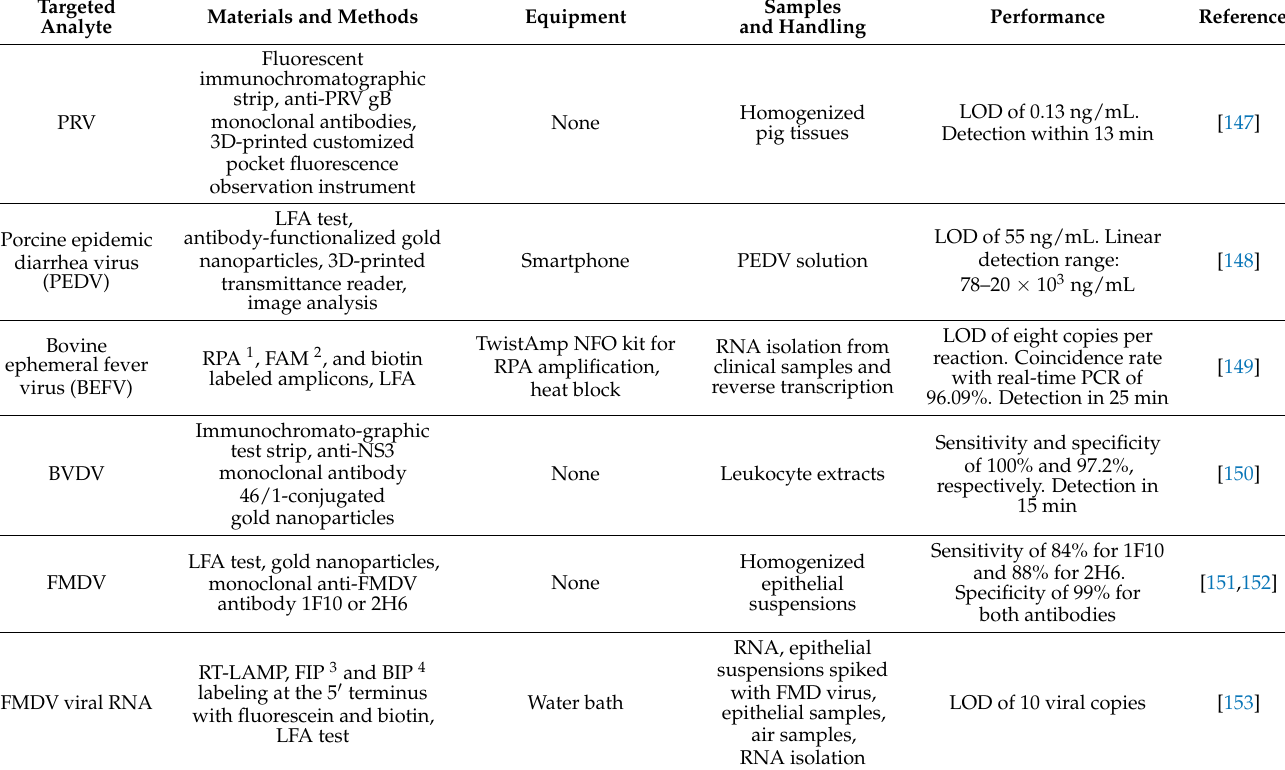
Table 2. Available LFA tests for the detection of animal